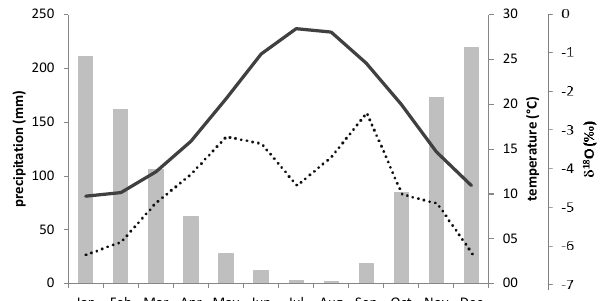
Figure 2. Long-term monthly data of average precipitation (grey bars) and air temperature (solid line) from Köycegiz meteorology station (1976–2010) and isotopic composition of precipitation in Antalya (dashed line). Data from Antalya are available at the IAEA database WISER (http://www-naweb.iaea.org/napc/ih/index.html, last access: 19 May 2014).